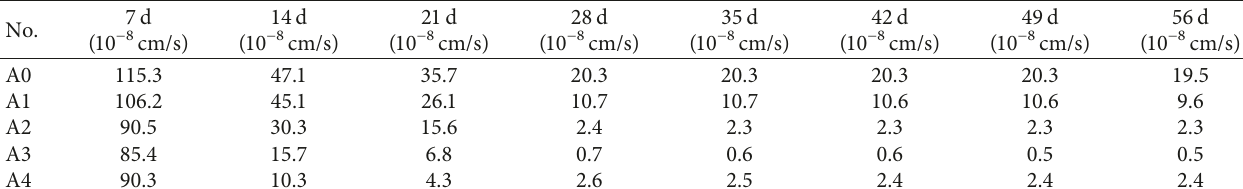
Table 8: Permeability coefficient under different curing periods.